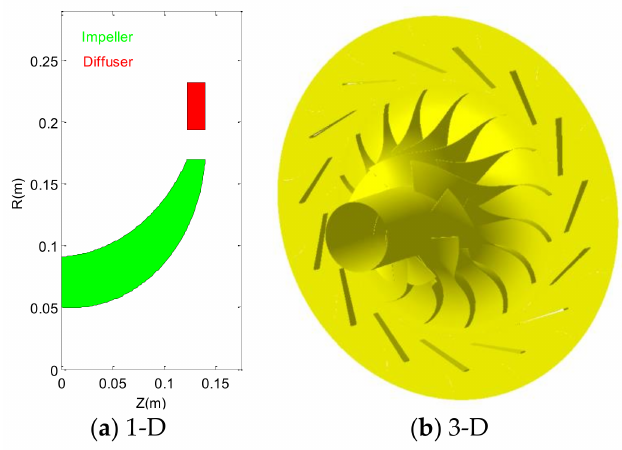
Figure 11. Centrifugal compressor (10 MWe). ( a ) Meridional plane; ( b ) 3D